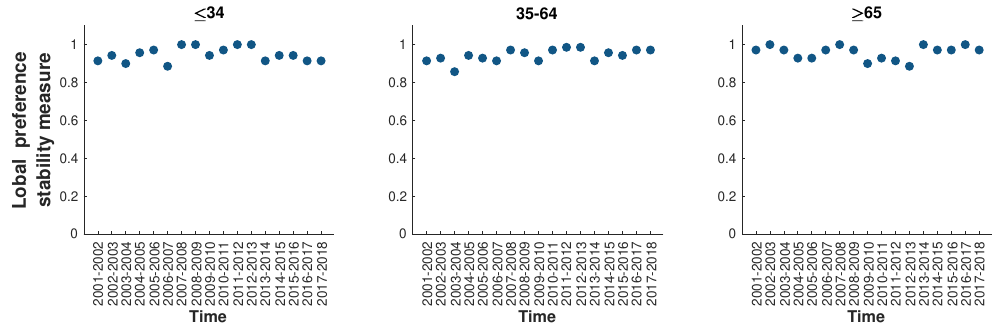
Figure A11. Graphic illustration of the local decision stability measures obtained for each age group and Question